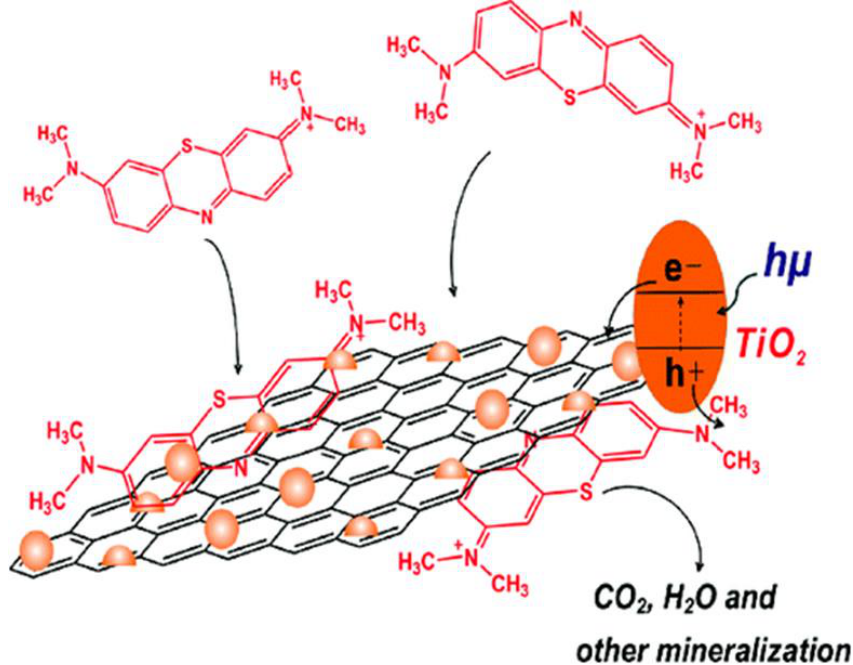
Figure 5. Photocatalysis mechanism of GO/TiO 2 heterojunction. Reprinted with permission from [112]. Copyright 2010 American Chemical Society.